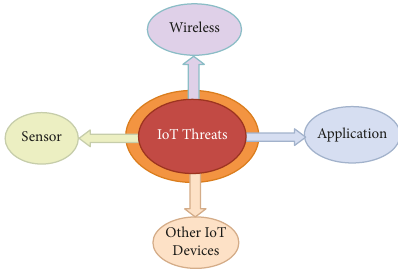
Figure 3: Dimensions of IoT threats.